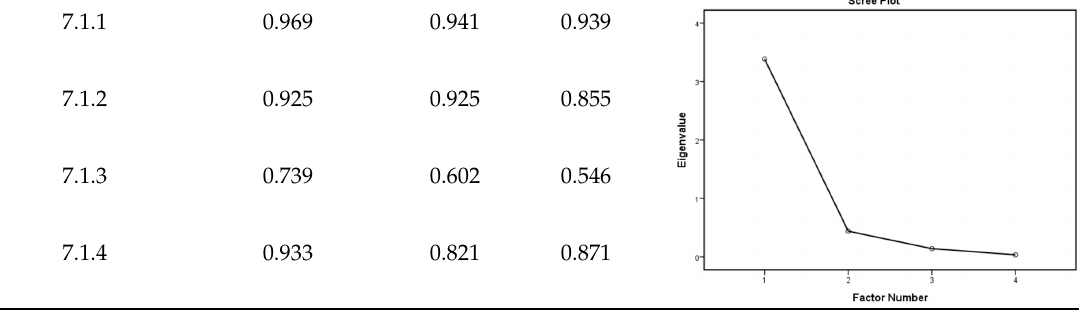
Table 4. Compliance with standards: distribution, floor, and ceiling effects.